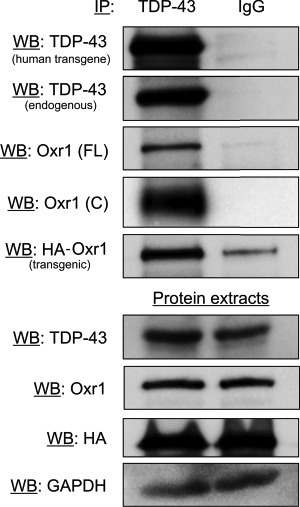
Oxr1 binds to TDP-43 in vivo. Co-IP in spinal cord tissue from a TDP-43M337V/M337V/Oxr1Prnp/− mouse using a pan-TDP-43 antibody (left lanes) and non-specific IgG (right lanes). Lower panels represent input loading controls. Antibodies used for western blotting are indicated. The Oxr1 antibody recognises both the TLDc domain-containing endogenous full-length Oxr1-(FL) and the shortest isoform Oxr1-(C).